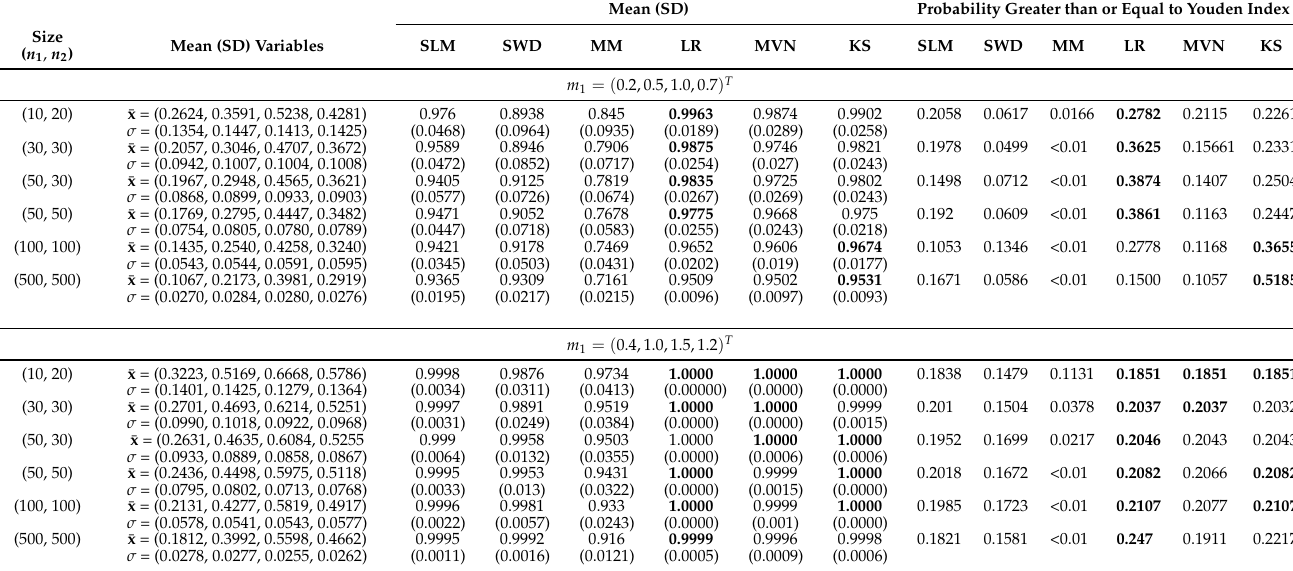
Table 7. Normal distributions: Different means. Negative correlation ( −